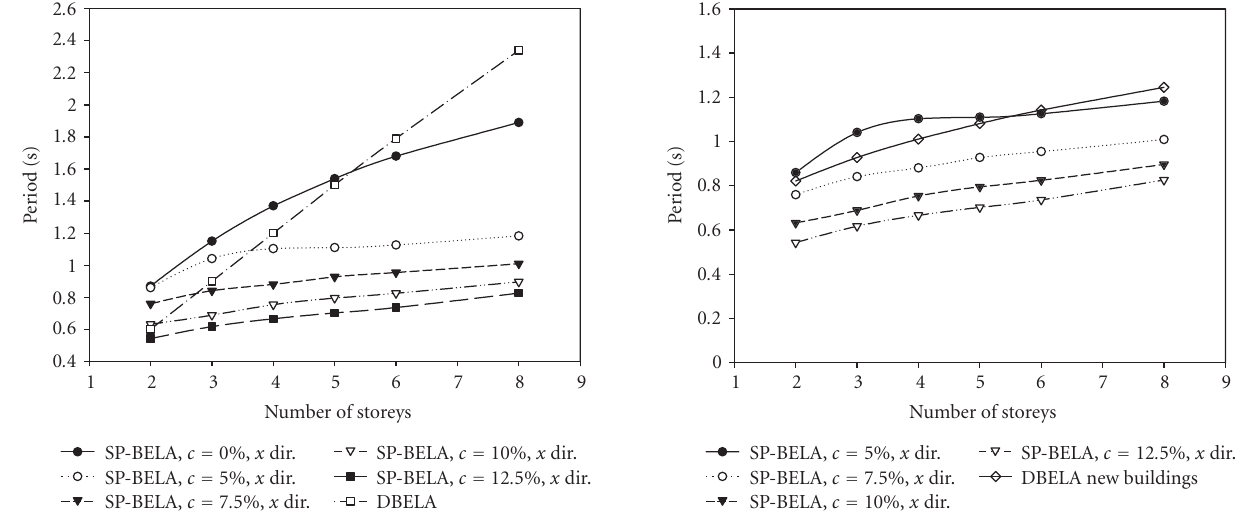
Figure 8: Mean yield period of vibration versus number of storeys for DBELA compared with each of the SP-BELA design categories in the x direction.